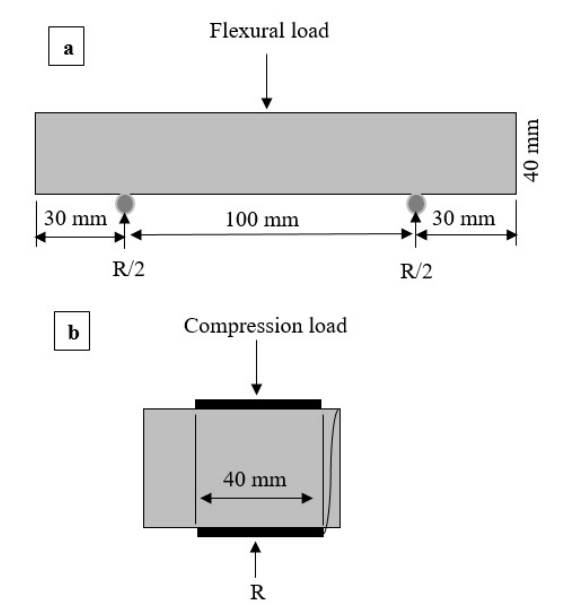
Figure 1: Experimental program presentation of cement mortar mod- ified lime (a) mixing, (b) setting time, (c) cube samples for strength tests (d) flexural test and (e) shape of failure Cement mortar preparation (BS EN 196-1:2016)